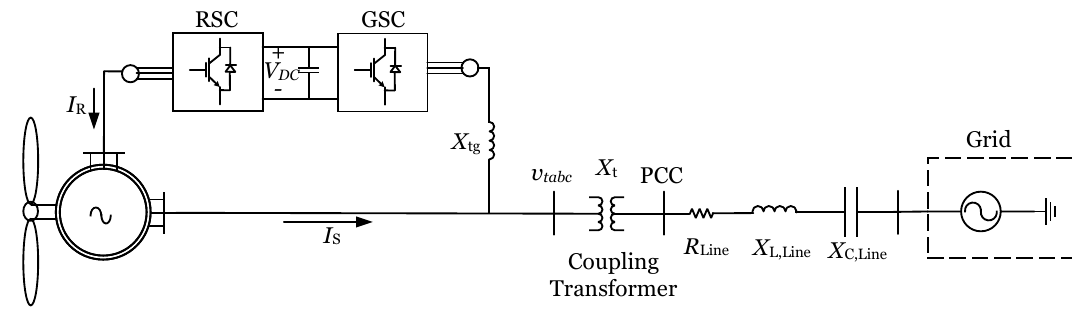
Figure 4. Schematic diagram of a Type III wind